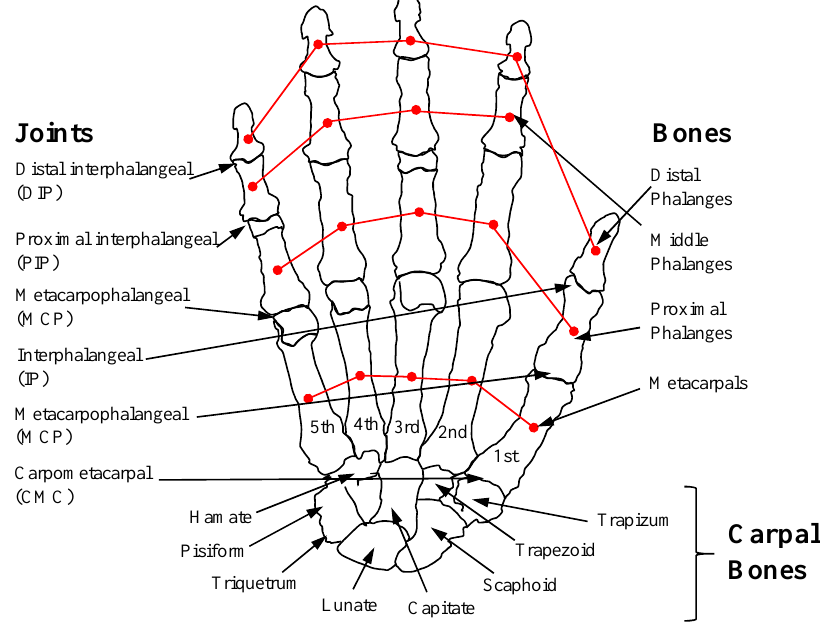
Figure 2. Skeletal structure of the human